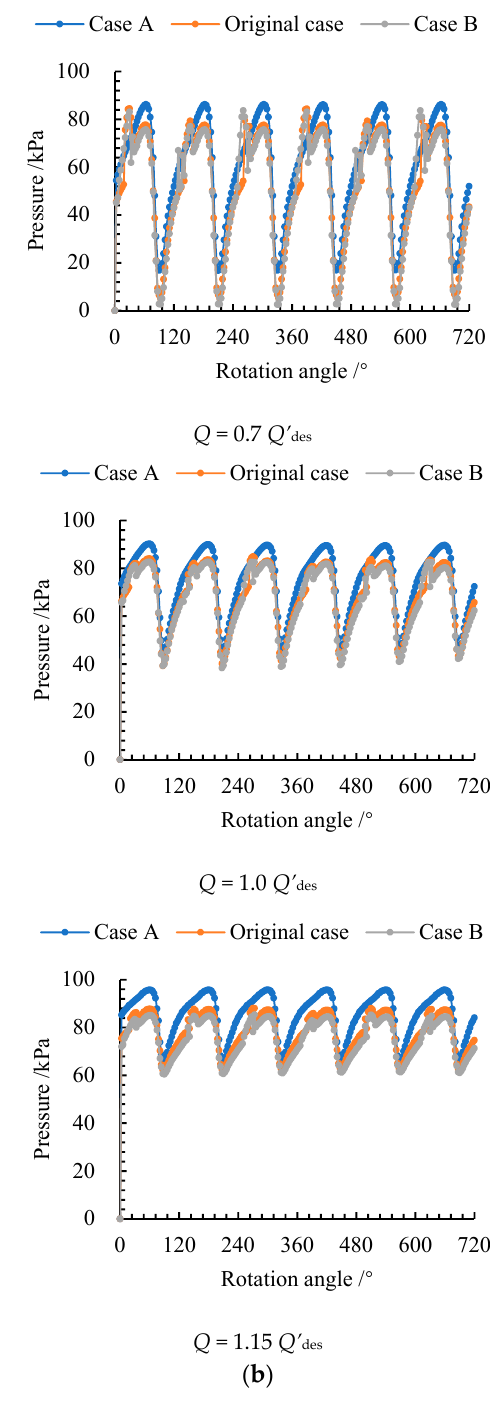
Figure 18. The time domain of pressure signal on A1 of three cases under ( a ) forward condition and ( b ) reverse condition.